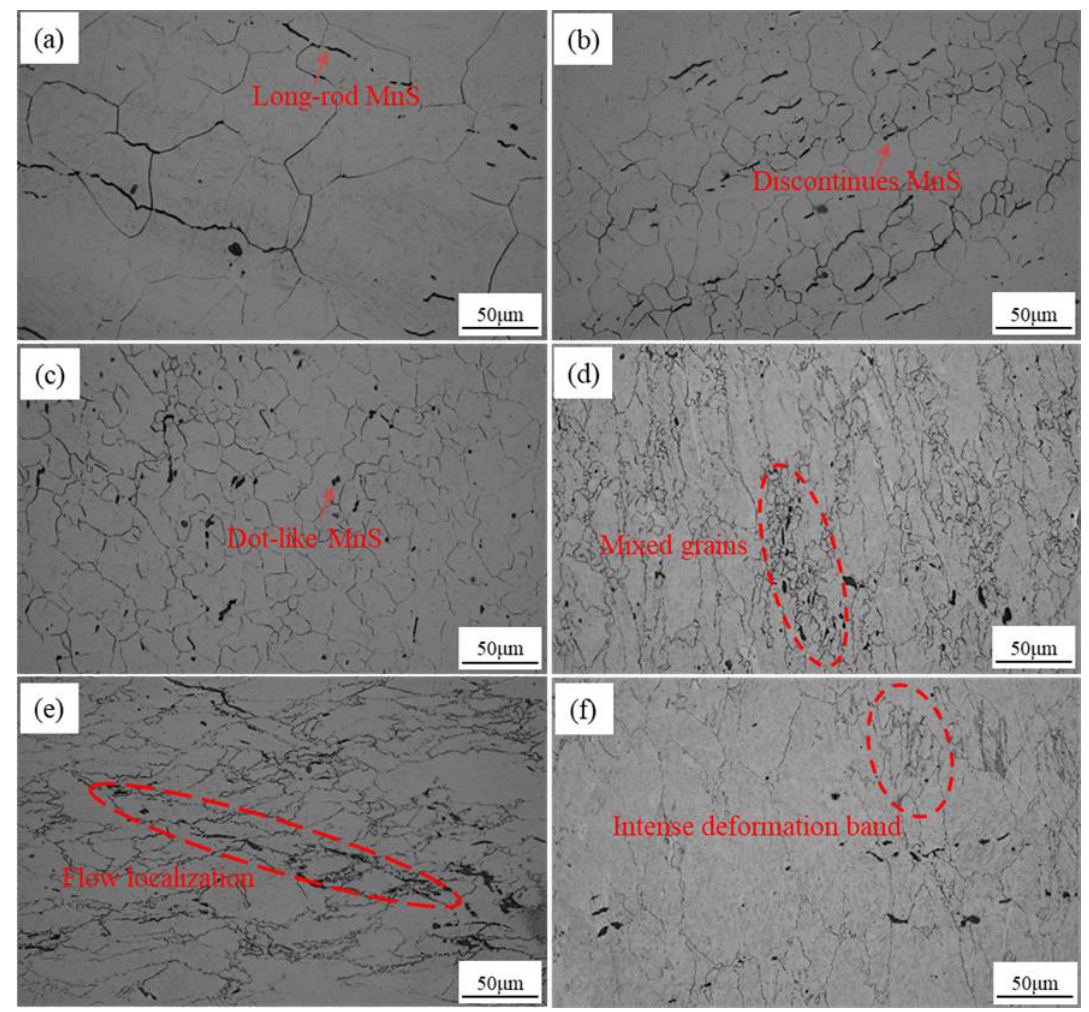
Figure 8. Optical micrographs of the specimens deformed under different conditions. ( a ) 1250 °C, 0.01 s −1 ; ( b ) 1250 °C, 10 s −1 ; ( c ) 850 °C, 0.01 s −1 ; ( d ) 850 °C, 10 s −1 ; ( e ) 950 °C, 10 s −1 ; ( f ) 1050 °C, 10 s −1 .